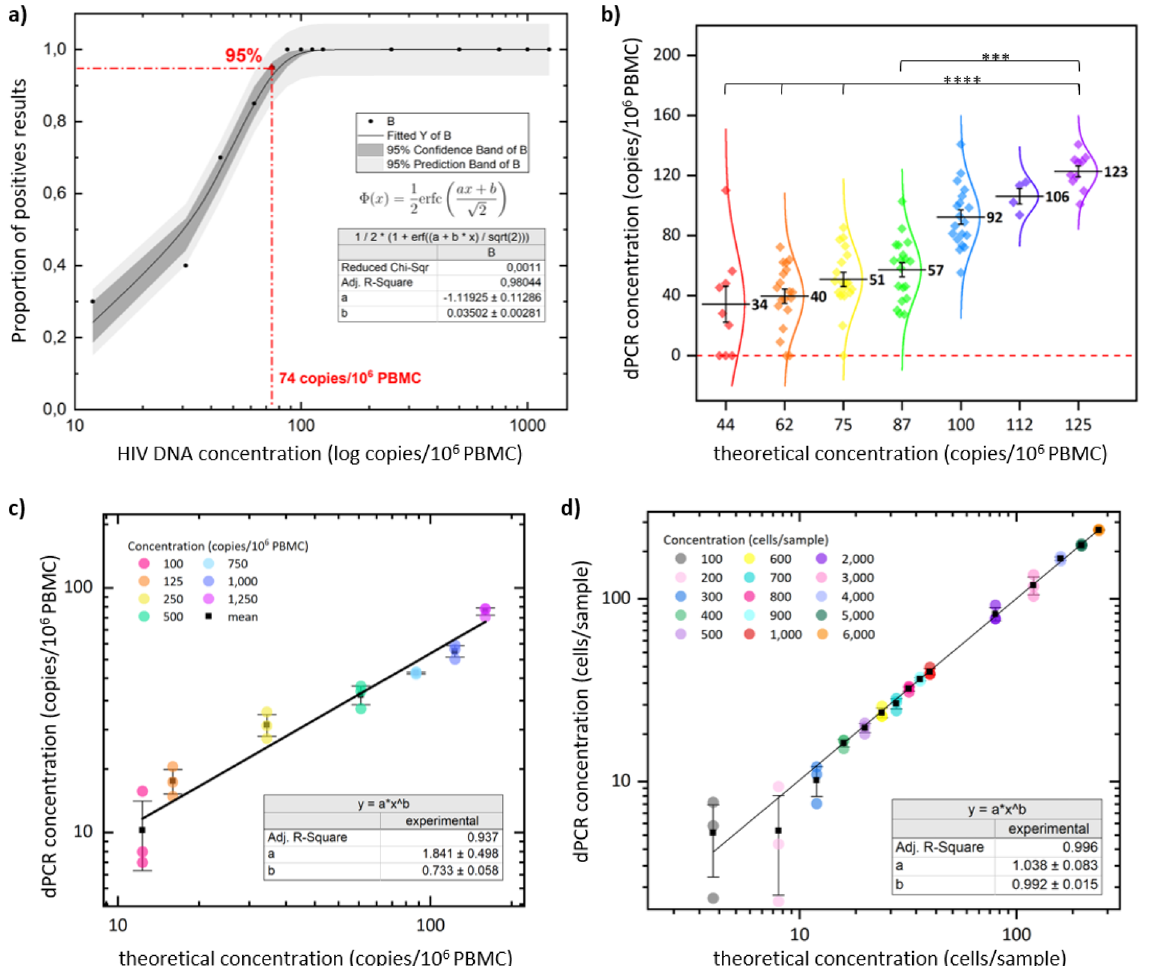
Figure 2. LOD95%, LOQ, and linearity study of the HIV DNA target in FAM and the β-globin target in VIC. ( a ) LOD95% of the target HIV-DNA in FAM is determined by a probit analysis at 74 copies/10 6 PBMC. ( b ) shows dPCR replicates with concentrations ranging from 44 to 125 copies/10 6 PBMC. The significant differences are indicated between the value of the LOQ and the other tested concentrations. ( c ) and ( d ) show linearity experiments where the data was fitted with a linear model, and, in ( d ), the concentrations ranged from 100 to 6000 cells/sample. On ( b ) and ( c ), the x-axis shows the theoretical concentration, whereas the y-axis shows the concentration measured by dPCR in copies/10 6 PBMC, which allows the estimation of the LOD95% and LOQ for ( b ). The x-axis of ( a – d ) and the y-axis of ( b – d ) are displayed with a log